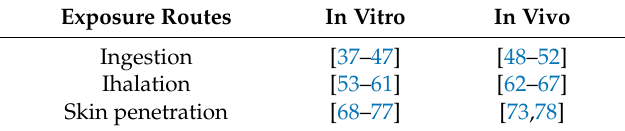
Table 1. Principal studies concerning the route of entry of inorganic NPs in vitro and in